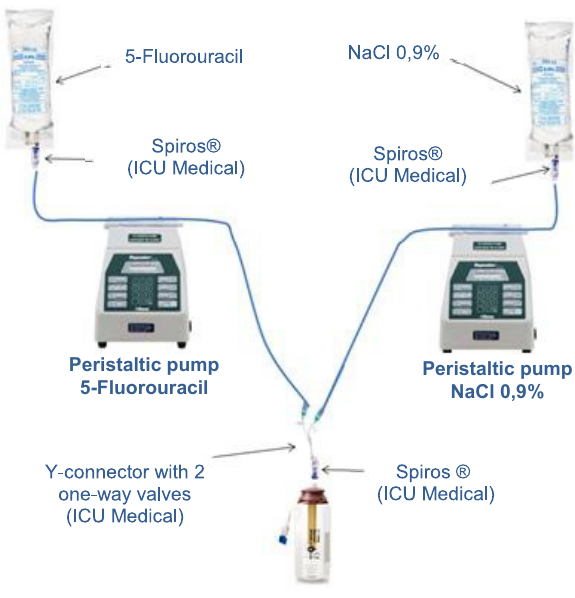
Figure 1: The studied